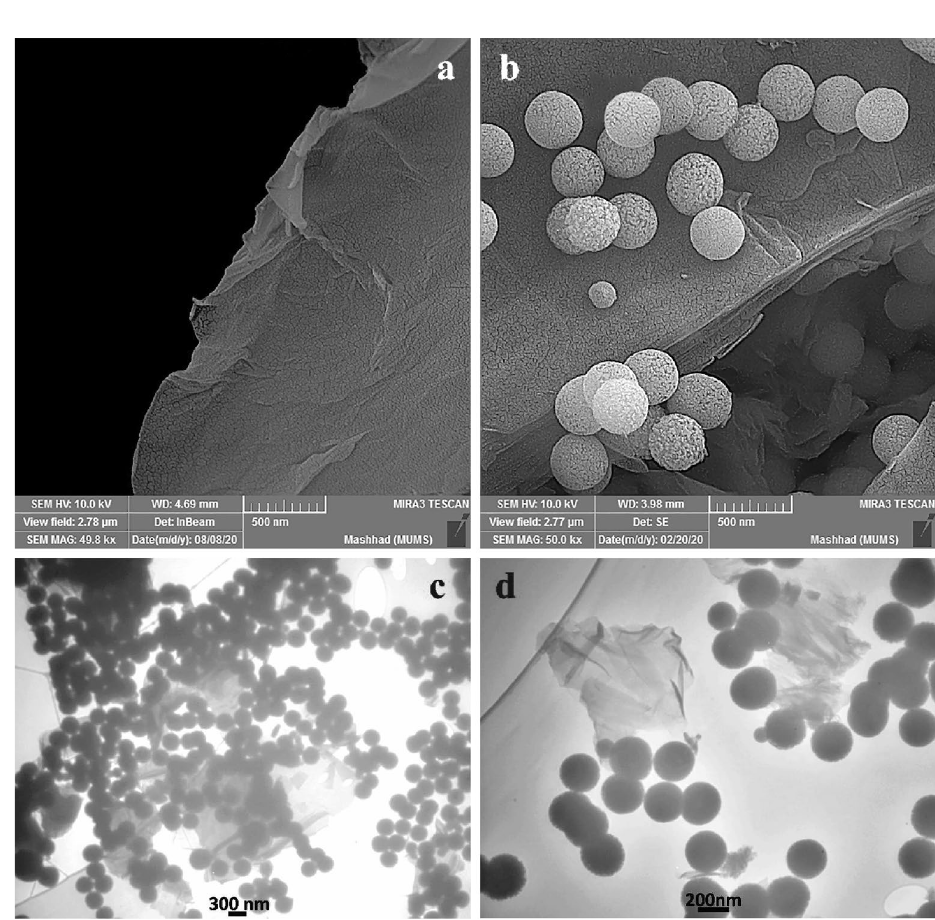
Figure 3. SEM images of GO ( a ), GO/f-SiO 2 /Co ( b ), TEM images of GO/f-SiO 2 /Co ( c , d